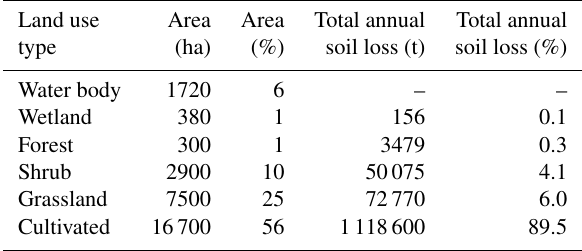
Table 7. Area coverage and amount of annual soil loss of each class and the corresponding average slope (%) values of the study